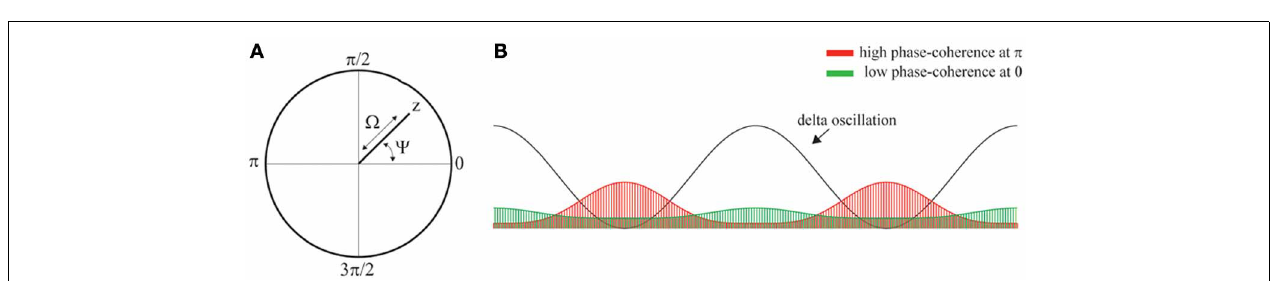
schematically denote the selected epochs. These epochs are shown in (B) , displaying DRDA with frequencies between 2 and 2.5Hz and amplitudes up to 150 μ V. The oscillations are dispersed with intermittent spikes.